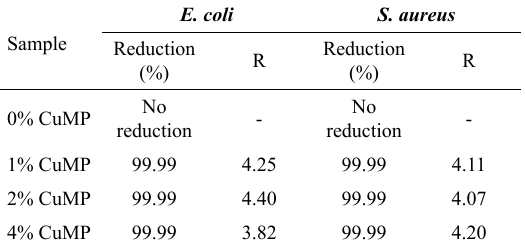
Table 5. Antibacterial activity of the compounds E. coli S. Sample